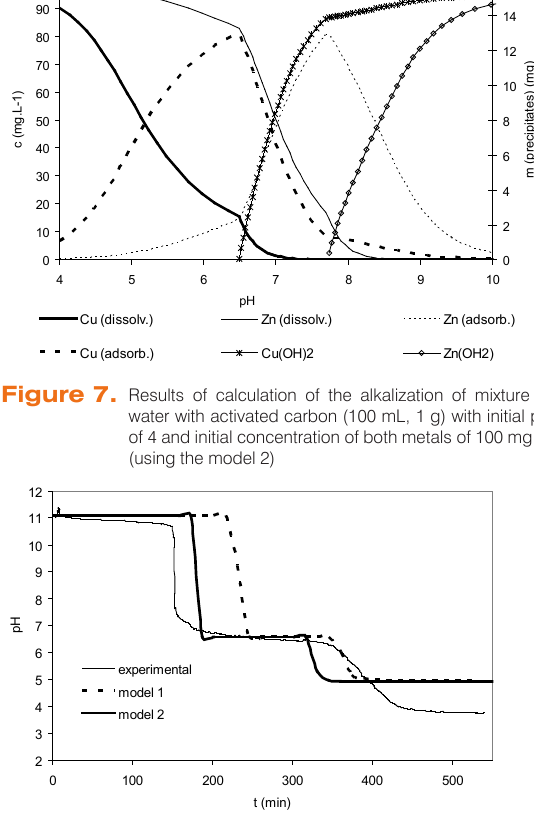
Figure 8. Effluent pH during the column experiment in comparison with the results of both models (oxides were considered as possible solid